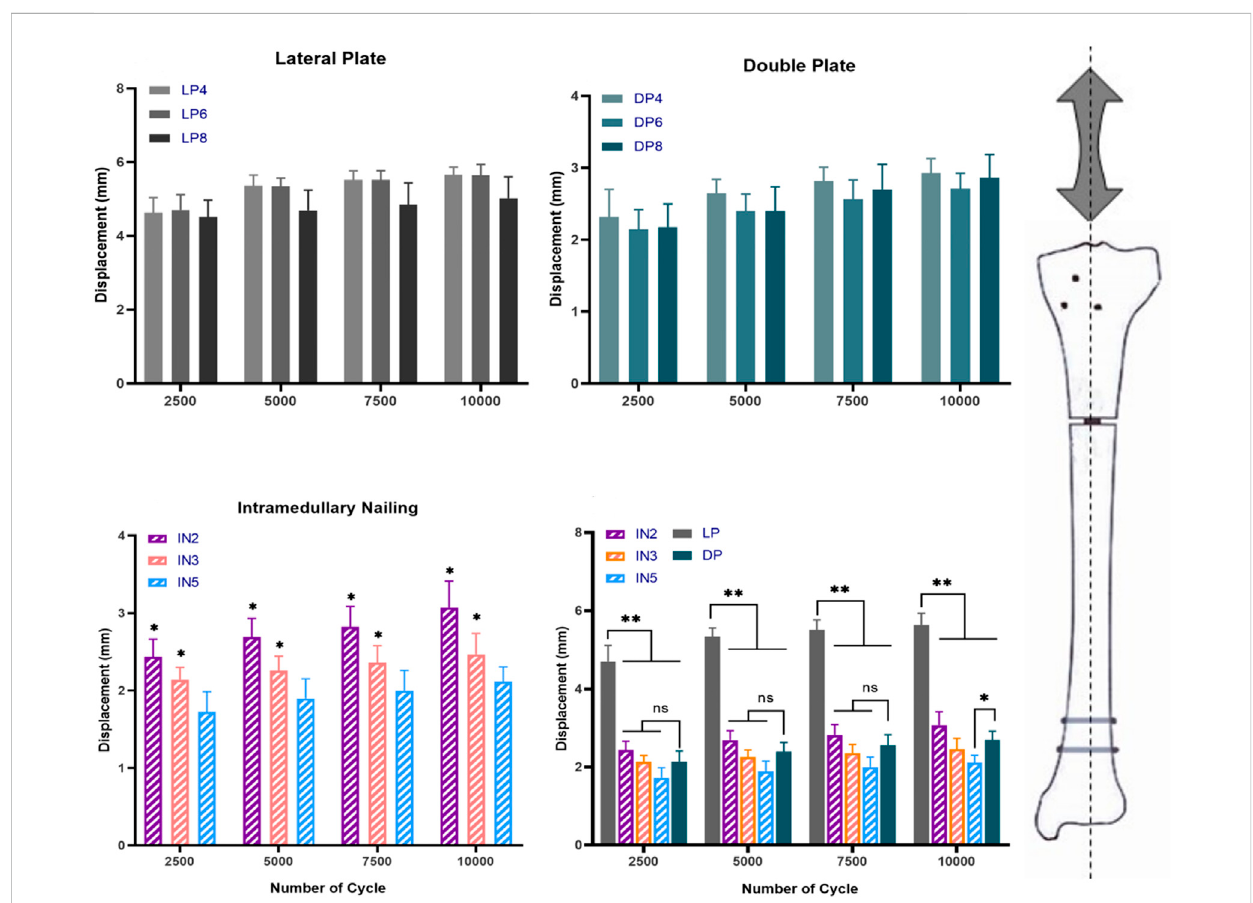
FIGURE 5 The different fi xation modalities: lateral plate fi xation groups (LP), double plate fi xation groups (DP), intramedullary nailing groups (IN) and multiple comparisons. Values represent the mean axial displacement of the proximal tibial fragment after 10,000 cycles under 400 N axial loads. (measured in mm). (ns, no signi fi cant difference; * p < 0.05; ** p <